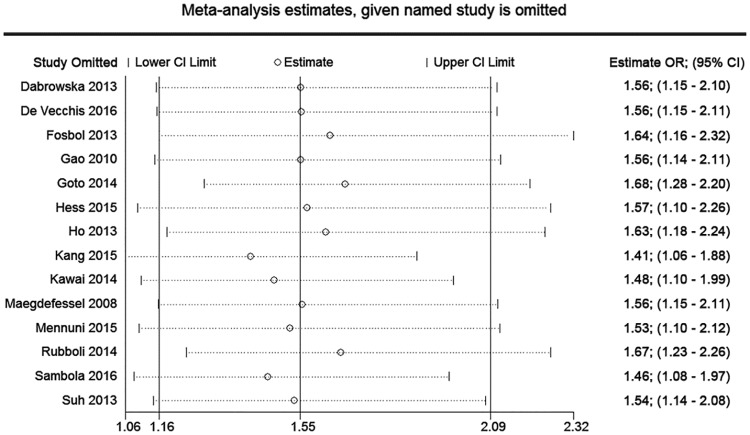
Plot of sensitivity analysis in major bleeding.